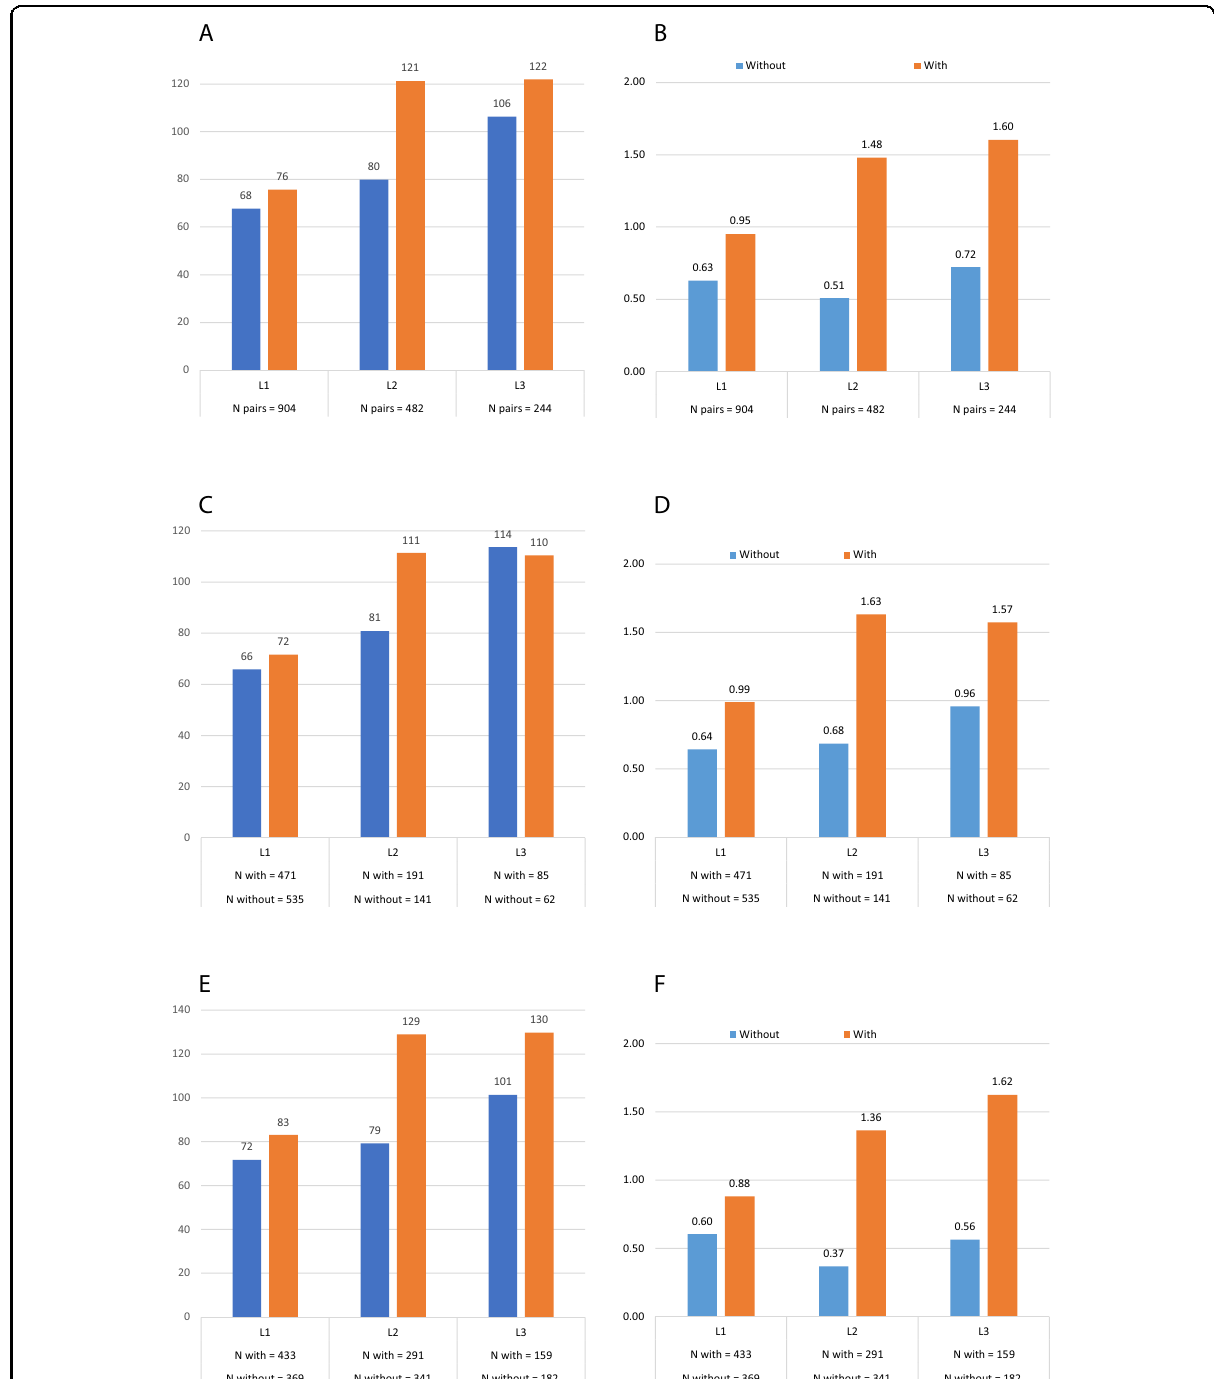
Fig. 4 IPTW adjusted annual healthcare resource utilization among patients with versus without progression by LOT. A Outpatient visits between 2006 and 2018; B Hospitalization between 2006 and 2018; C Outpatient visits between 2006 and 2012; D Hospitalization between 2006 and 2012; E Outpatient visits between 2013 and 2018; F Hospitalization between 2013 and “ with progression ” and “ without progression ” groups. The L1, $68,414 for L2, and $98,507 for L3 at 1-year post- index (Table 3). At subsequent years post-index, however, incremental cumulative total healthcare costs among patients in L1 with progression had lower costs than those patient with versus without progression were $11,863 for